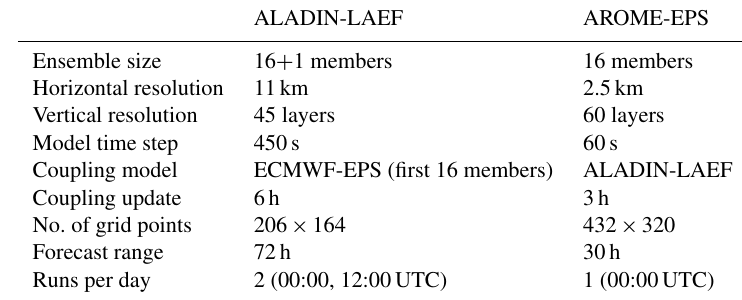
Table 1. Main characteristics of the ALADIN-LAEF and AROME-EPS.